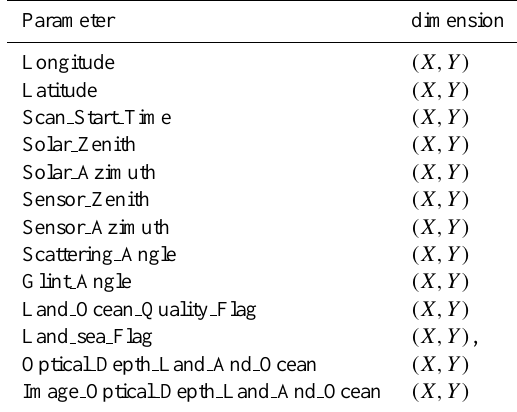
Table 1. Land and ocean parameters of the MOD/MYD04 3K file and the parameter’s